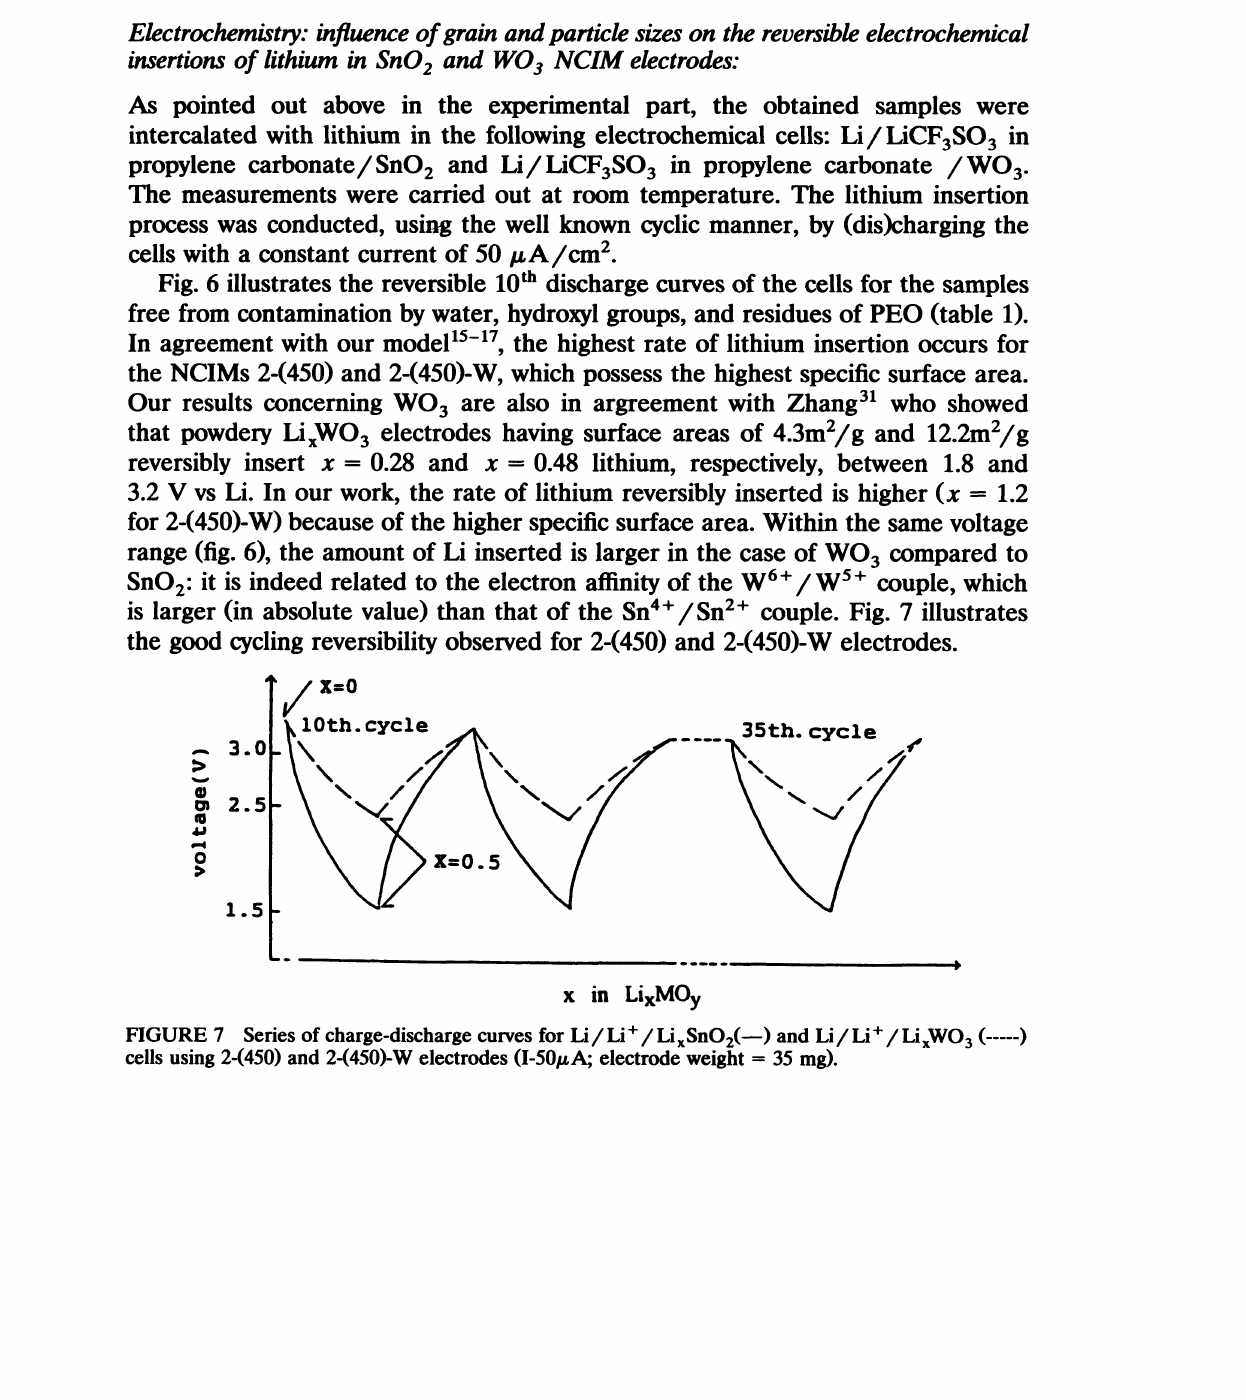
FIGURE 7 Series of charge-discharge curces for Li/Li +/LixSnO2(--) and Li/Li +/LixWO cells using 2-(450) and 2-(450)-W electrodes (I-50/zA; electrode weight 35